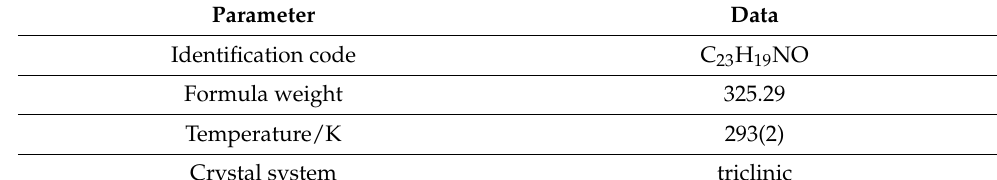
Figure 1. (A) ORTEP diagram of ( Z )-5-benzylidene-4-phenyl-2-( p -tolyl)-4,5-dihydrooxazole ( 15 ) with thermal ellipsoids at the 50% probability level. (B) Packing diagram of 15 along the b axis. Atom colors: (a) blue = nitrogen, (b) white = hydrogen, (c) red = oxygen, (d) grey = carbon. Interaction colors: (e) green line = π−π stacking interaction, and (f) yellow line = CH- π interaction. Table 1. Summary of the crystallographic data and refinement statistics for 15 .